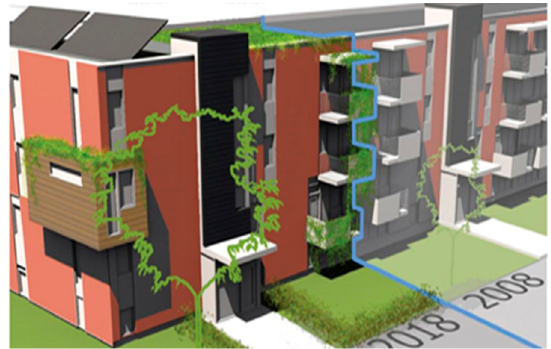
Figure 7. Stages of improvements from 2008 to 2018 in Atelier Rosemount, Montreal [22] (Reprinted with permission of CMHC and credit L’OeuF s.e.n.c.)